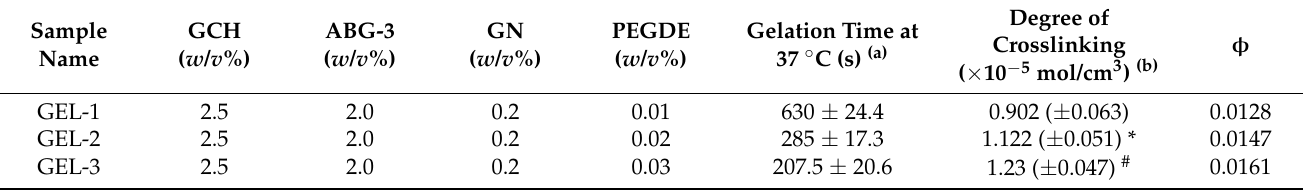
Table 3. Parameters for dual-crosslinked